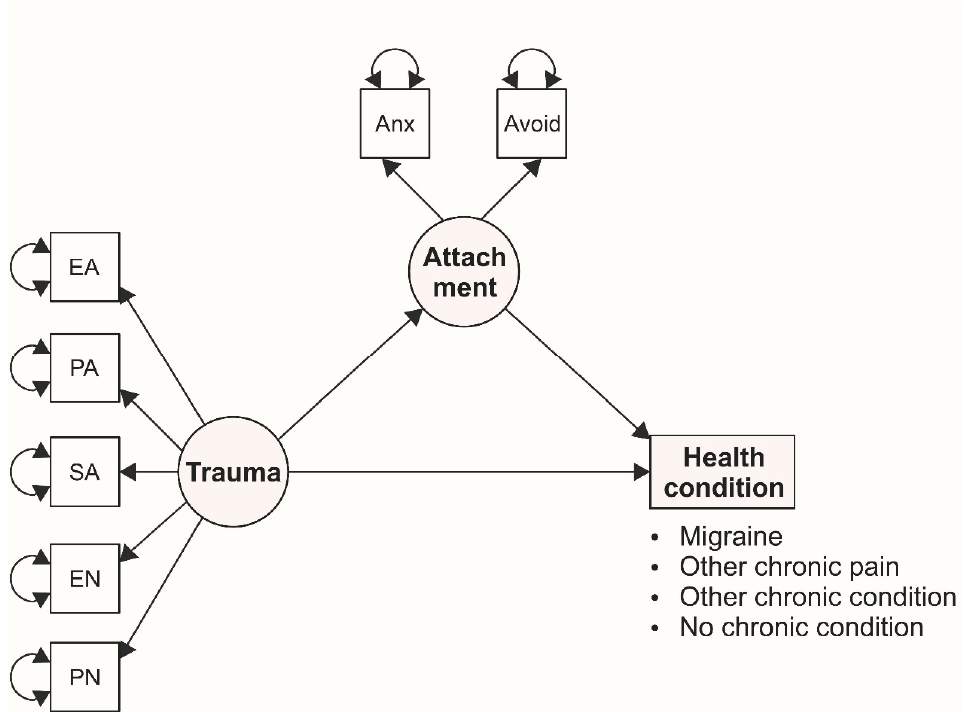
Figure 1. Hypothesized mediation models for various adulthood health conditions. Note: Trauma = latent variable assessing childhood trauma, Attachment = latent variable assessing adulthood attachment; EA = emotional abuse, PA = physical abuse, SA = sexual abuse, EN = emotional neglect, PN = physical neglect; Anx = anxiety, Avoid = avoidance.